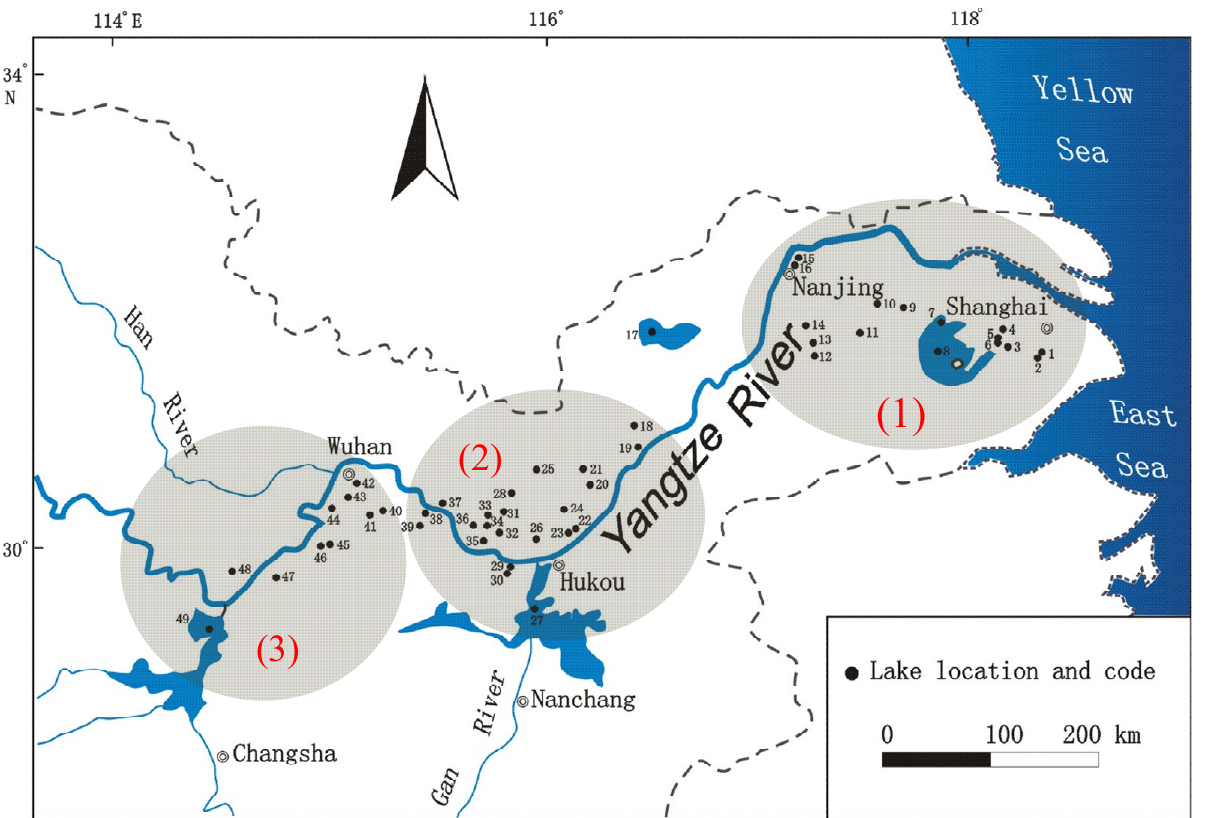
Figure 1. Location of sampled lakes along the middle and lower Yangtze